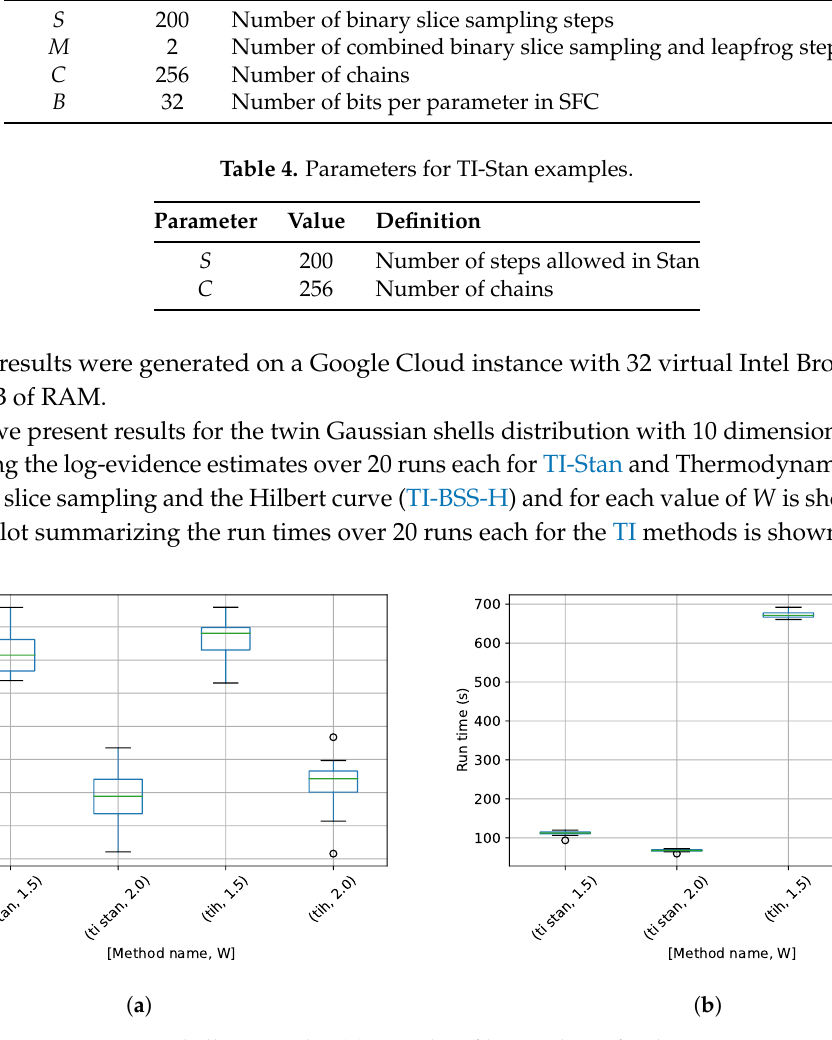
Figure 1. Twin Gaussian shell test results. ( a ) Box-plot of log-evidence for the 10-D twin Gaussian shell problem for TI-Stan and TI-BSS-H; ( b ) Box-plot of run time in seconds for the 10-D twin Gaussian shell problem for TI-Stan and